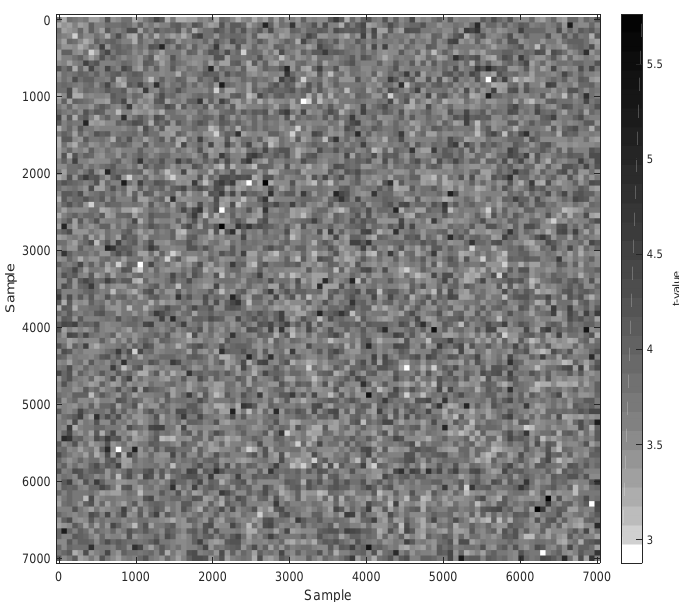
Figure 5: Second-order leakage for three-share version with four coefficients (masks enabled, 1 M measurements, t th = 6 . 36). Points with t -values above the threshold are highlighted red (none